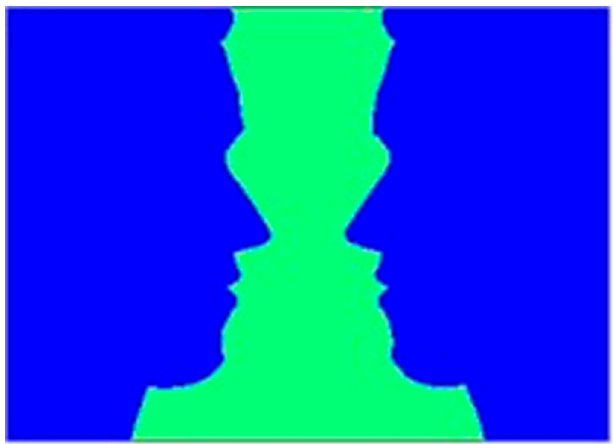
Figure 1. A color-gustatory synesthete, E.C., reported that the blue “tasted very sweet” and the green tasted “fresh, like rain with no humidity, a hint of cilantro, slightly tangy”. In this figure, both tastes were not experienced simultaneously. The taste depended upon the color of the figure that was perceived—faces or urn. Her synesthetic tastes ‘flipped’ along with her visual reversals.